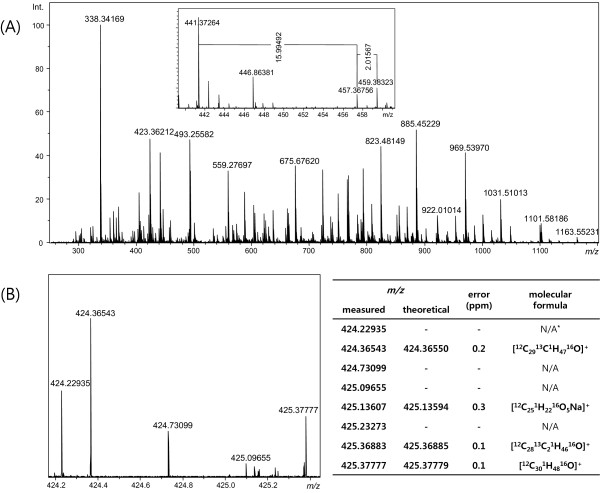
UHR MS spectrum of ginseng extract. (A) The UHR mass spectrum of ginseng extract obtained by a 15 T FT-ICR mass spectrometer. (B) The zoomed spectrum shows that the resolution was sufficient to resolve all peaks within a 1-amu span. The molecular formulae determined by IFS are listed in the side table.